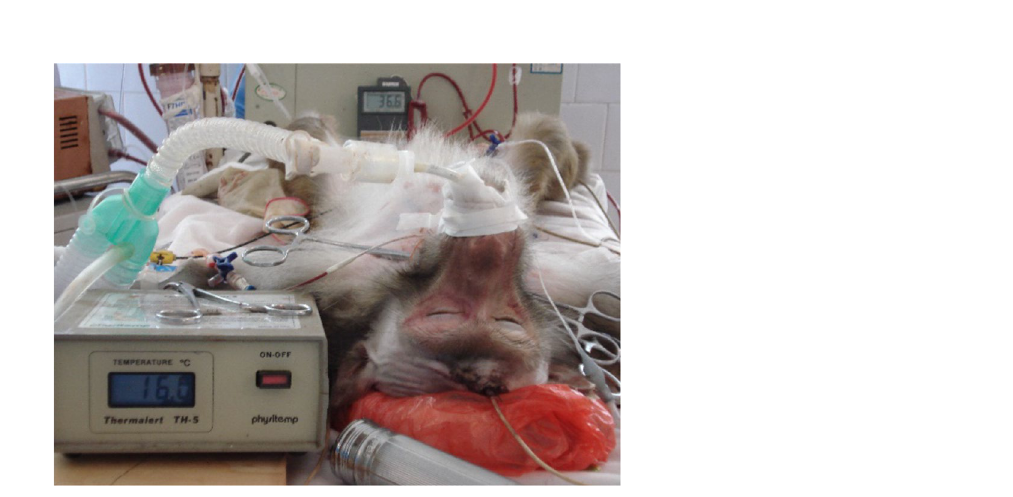
Figure 5. Schematic diagram of the hypothermic diversion vessels.